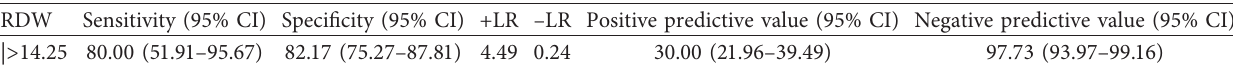
Table 2: Sensitivity, specificity, positive likelihood ratio (+LR), negative likelihood ratio (LR), positive predictive value, and negative predictive value of RDW for mortality at the optimal cutoff level.